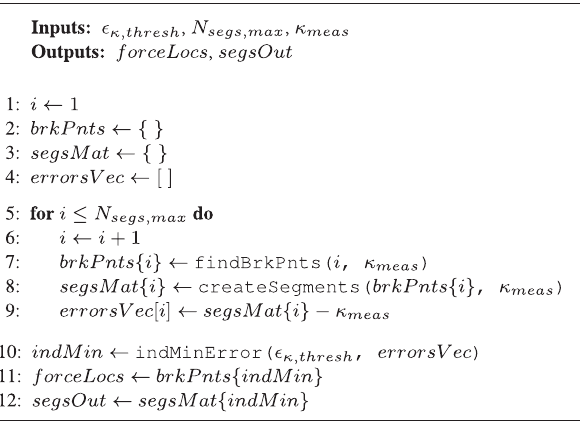
Algorithm 1 Curvature error thresholding